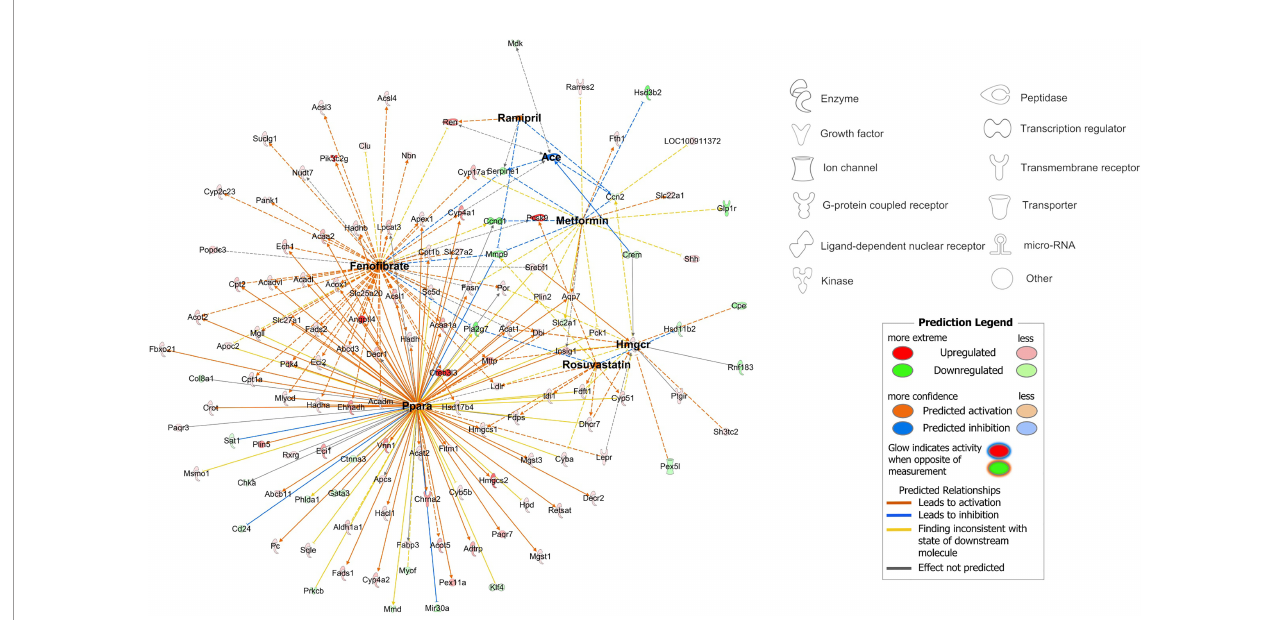
FIGURE 5 | Network visualisation of medication-responsive genes which were differentially expressed between the RYGB-FMRR and RYGB groups. The network was constructed using the ‘ My Pathways ’ interface in IPA, and edited using ‘ PathDesigner ’ in IPA. The four medications administered to rats treated with RYGB-FMRR, and their corresponding drug targets, are bolded. The legend outlines node symbols corresponding to molecule types contained within the network. The directionality of gene expression change in the RYGB-FMRR vs RYGB DEG list is displayed by node colour (red = upregulated; green = downregulated). Relationships between medications and their gene targets are illustrated by edge colour (orange = predicted activation; blue = predicted inhibition). DEG, differentially expressed gene; IPA, Ingenuity Pathway Analysis; RYGB, Roux-en-Y gastric bypass; RYGB-FMRR, Roux-en-Y gastric bypass plus feno fi brate, metformin, ramipril, and